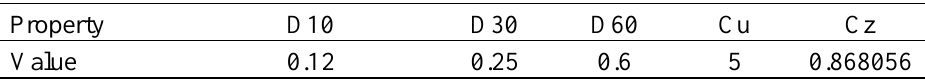
Table 1. Sieve analysis properties of used